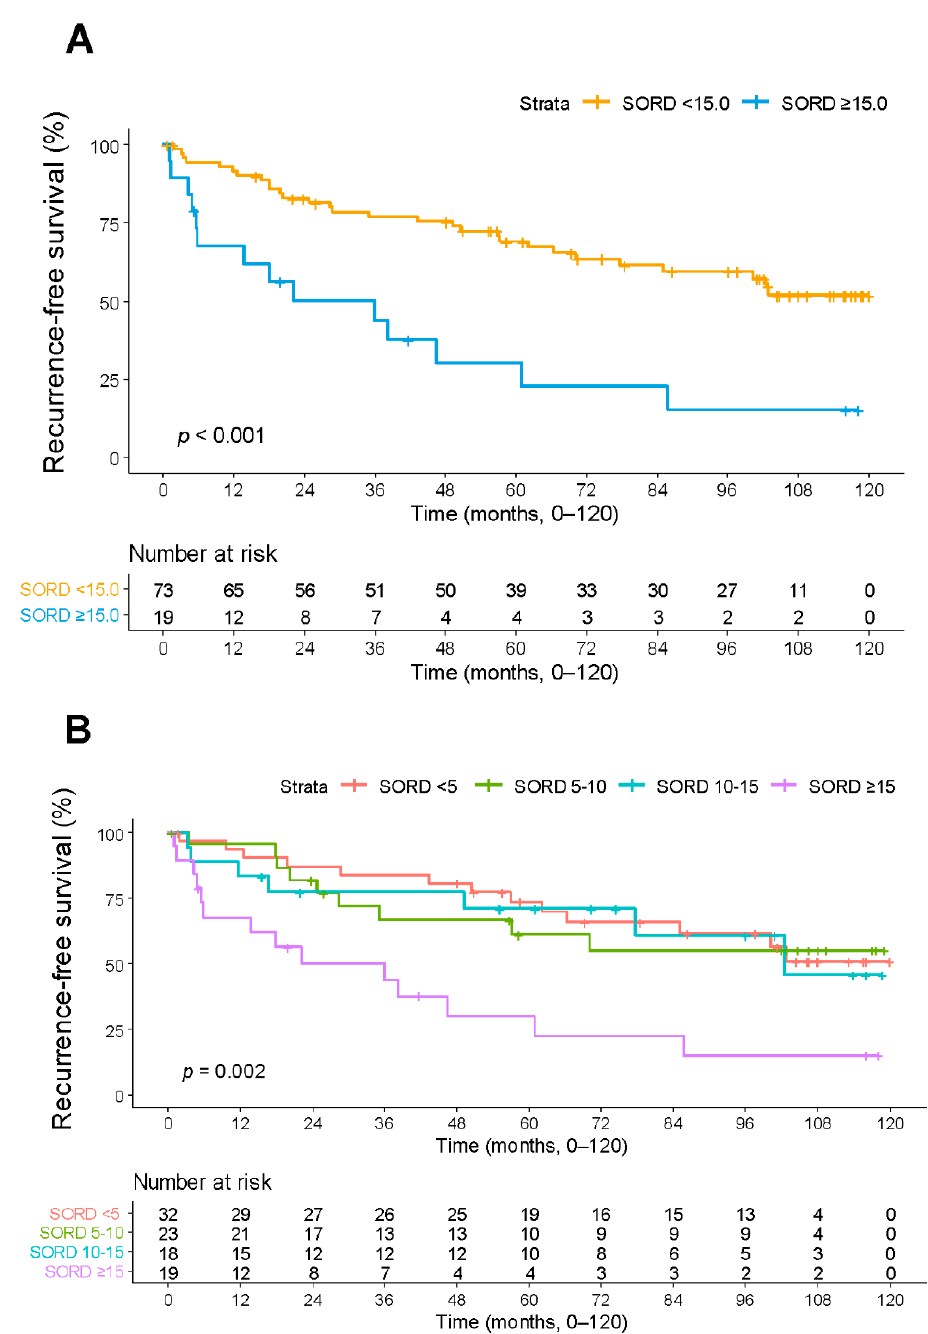
Figure 2. Kaplan–Meier plot for recurrence-free survival in patients with HCC after intent-to-cure resection stratified by serum SORD levels. ( A ) Patients stratified into two groups by baseline serum SORD level (<15 ng/mL and ≥ 15 ng/mL); ( B ) Patients stratified into four groups by baseline serum SORD level (<5 ng/mL, 5–10 ng/mL, 10–15 ng/mL, and ≥ 15 ng/mL).